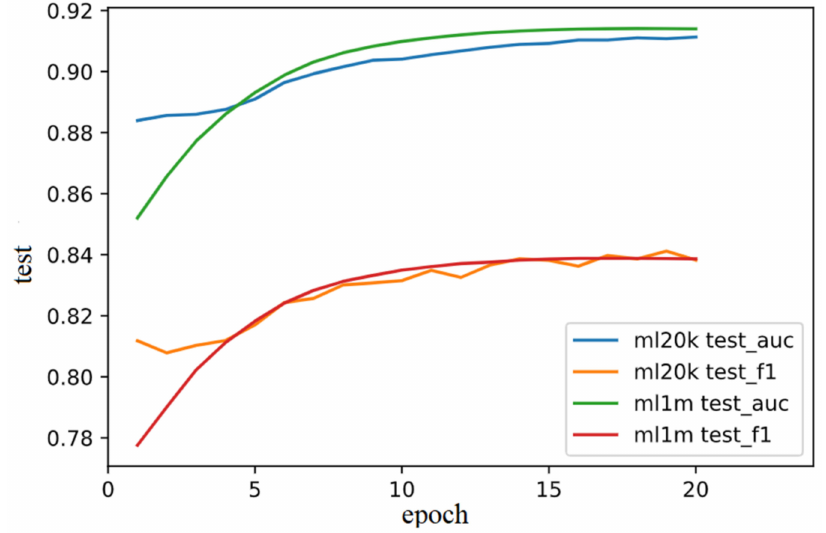
Figure 5. A reflection of the change in the AUC and f1 score of the CTR on the test